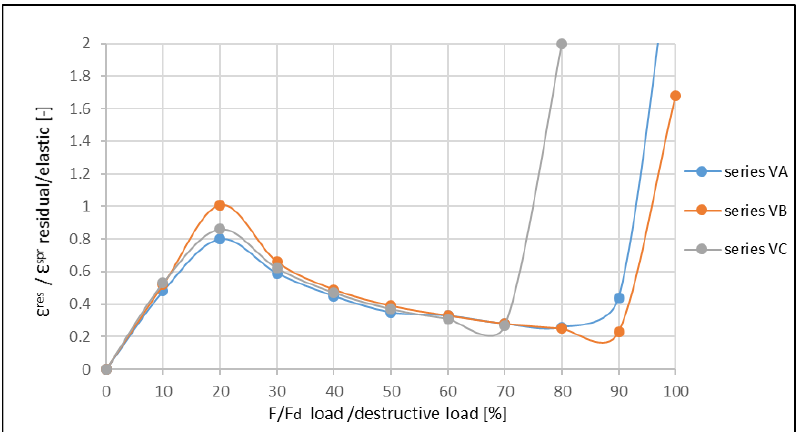
Figure 14. Example graph showing the ratio between residual and elastic strains regarding the ratio between the applied load and destructive load for the beams of V-th series.